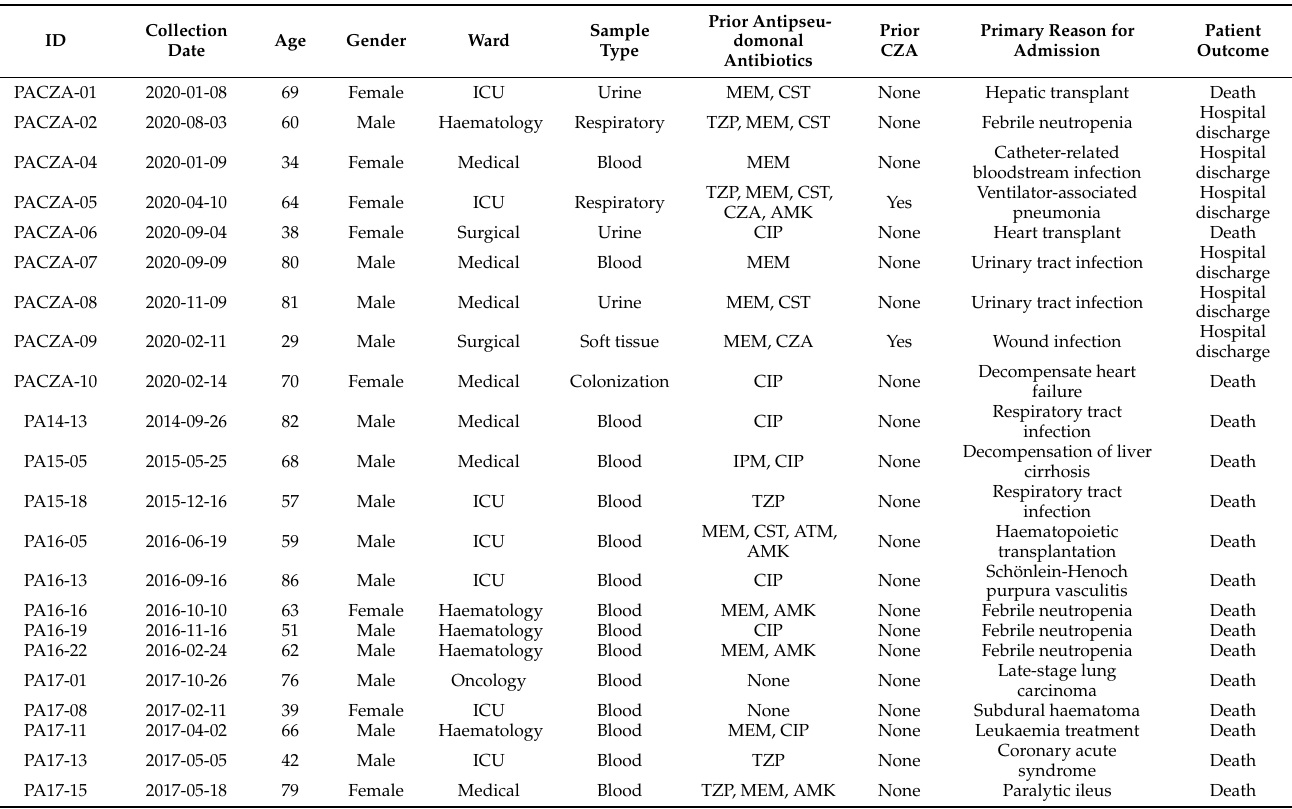
Table 1. Demographic and clinical characteristics of the study